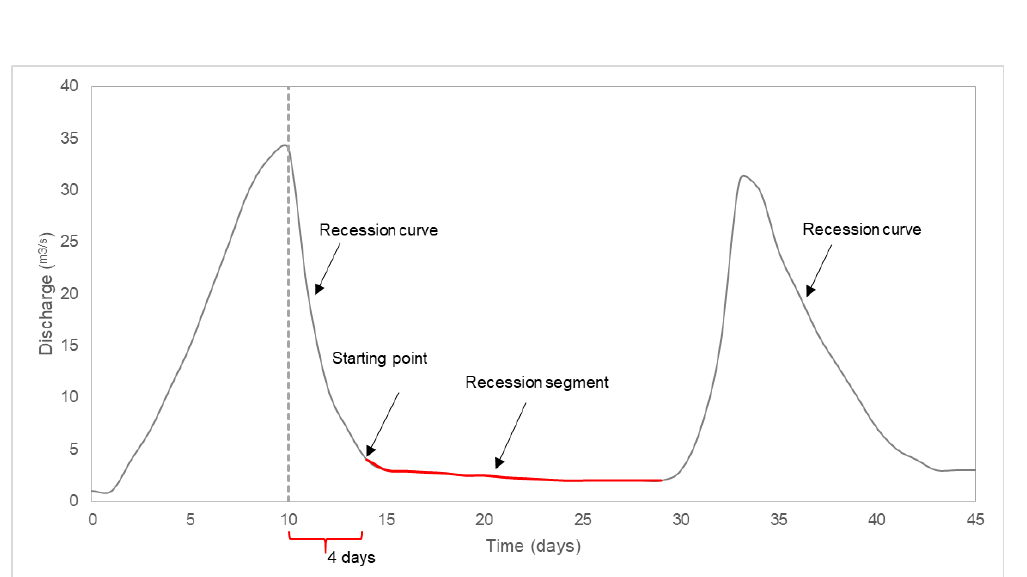
Figure 2. Schematic of recession segment selection.